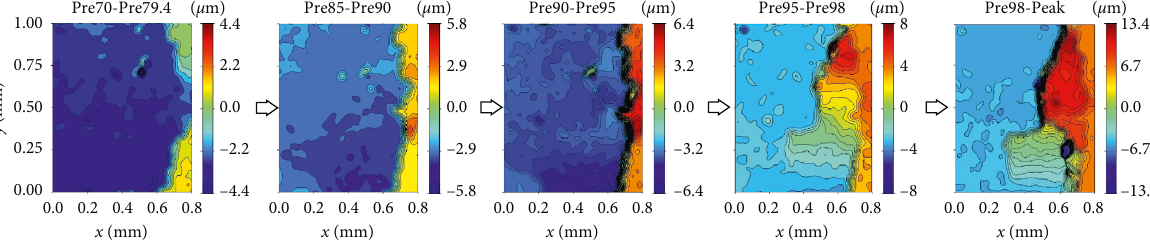
Figure 9: Distributions of horizontal incremental displacement at notch tip for specimen TPB-0.6-1 with the range of 0.8mm based on the DIC calculation obtained from the microscopic images under different loading levels.